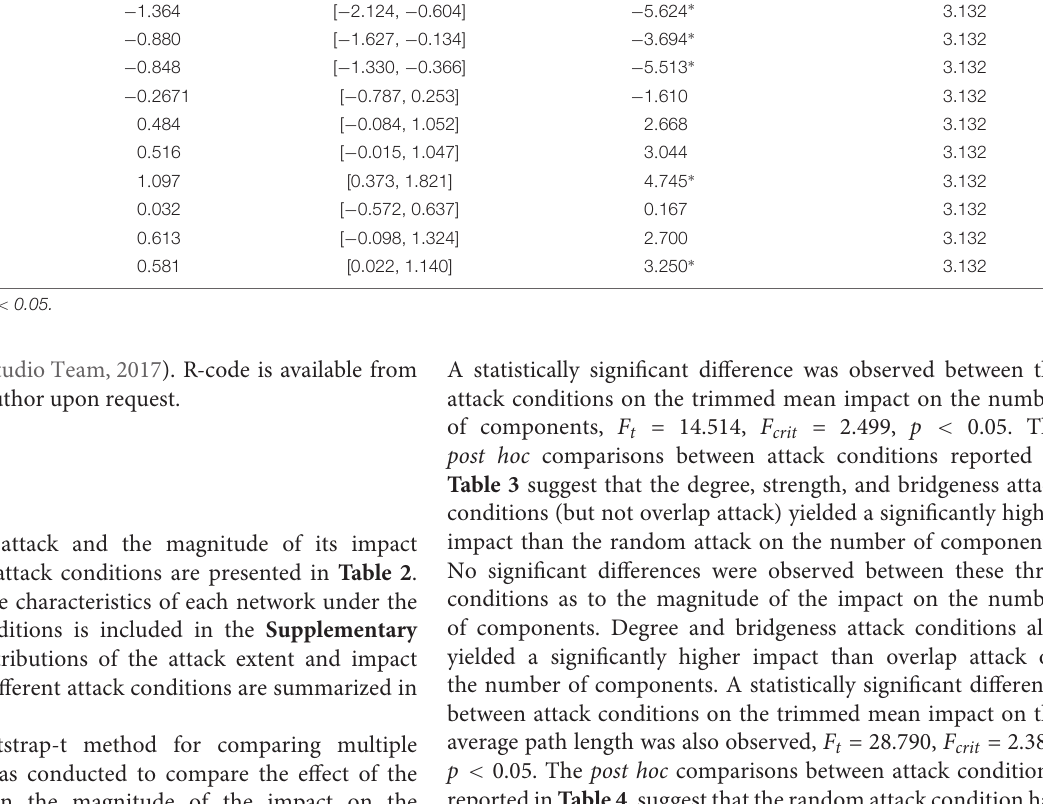
TABLE 3 | Post hoc comparisons between attack conditions of the magnitude of the impact on the number of components. Pairwise